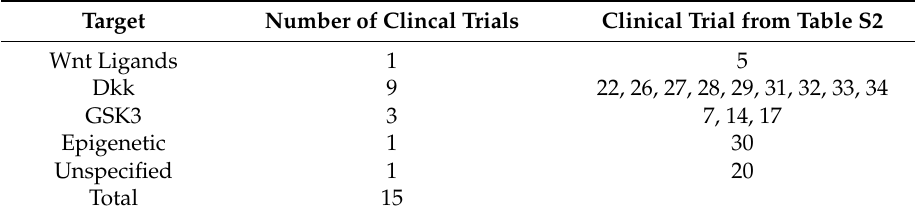
Table 5. Wnt signaling enhancer targets.